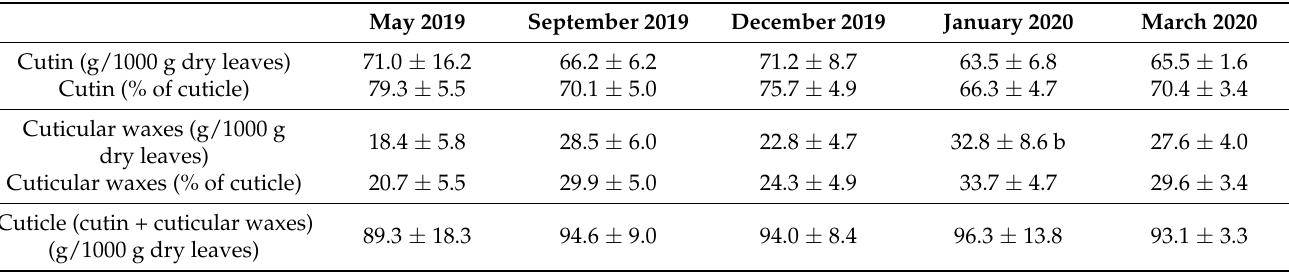
Table 1. Seasonal variation in cuticular waxes (as solubles by dichloromethane), cutin (as monomers solubilized by transesterification), and cuticle (as the sum of cutin and cuticular waxes), in mass proportion of dry leaf mass (g/1000 g) in leaves of Quercus suber (mean of six provenances with two trees per provenance and standard